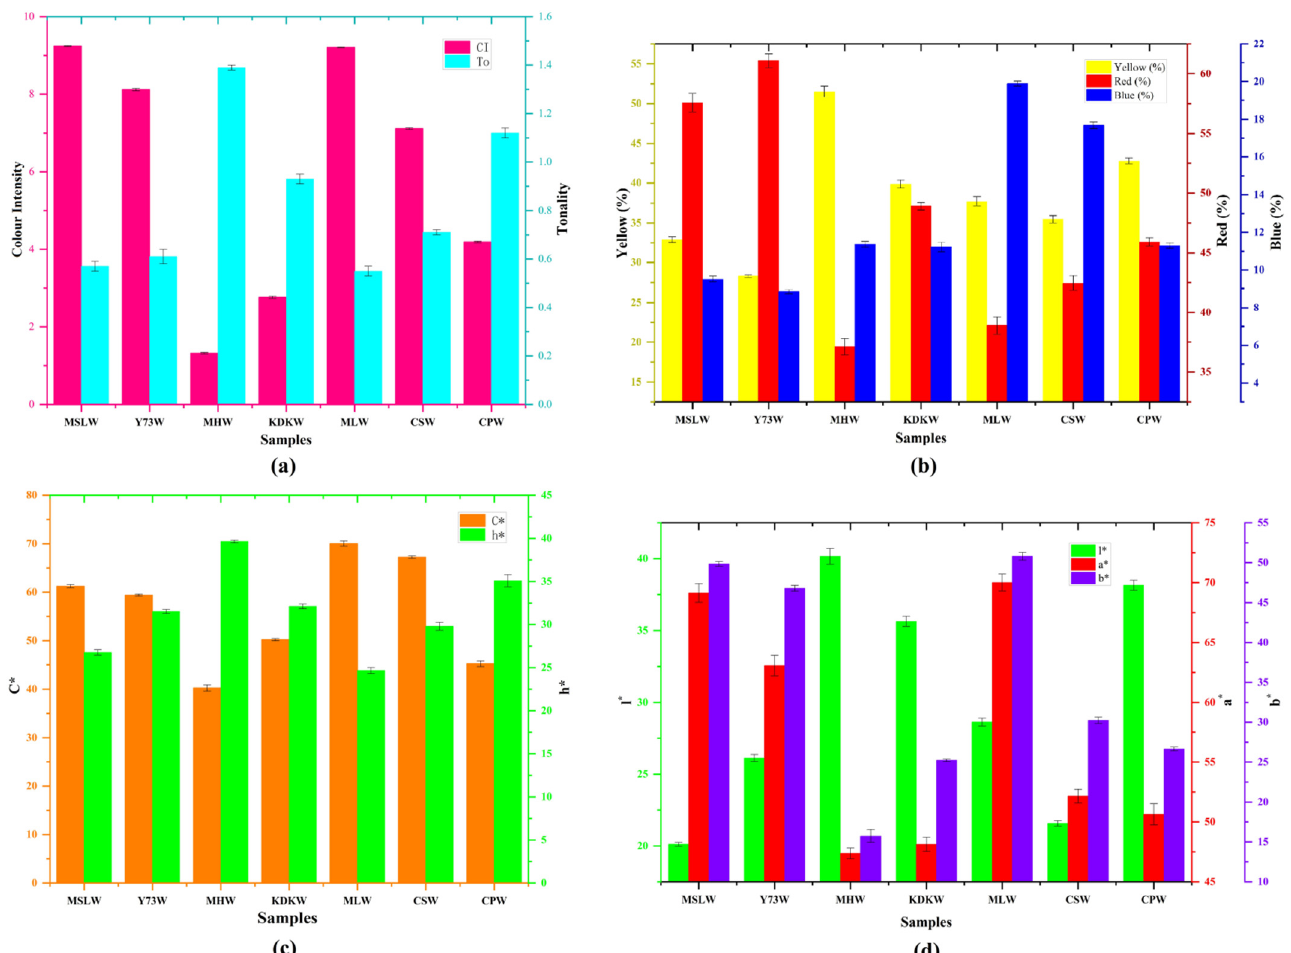
Figure 7. Color analysis of wines produced from seven different grape varieties. ( a ) Color intensity (CI) and tonality (To); ( b ) %Yellow, %Red, %Blue; ( c ) C* , h* ; ( d ) l* , a* , b* . The * is part of the full name to distinguish it from the letters C, h, l, a, b ( p ≤ 0.05). Samples’ full names, as follows: MSL (Marselan), Y73 (Yan 73), MH (Muscat Hamburg), KDK (Kadarka), ML (Merlot), CS (Cabernet Sauvignon) and CP (Crimpose). Furthermore, G represents “grape” and W represents